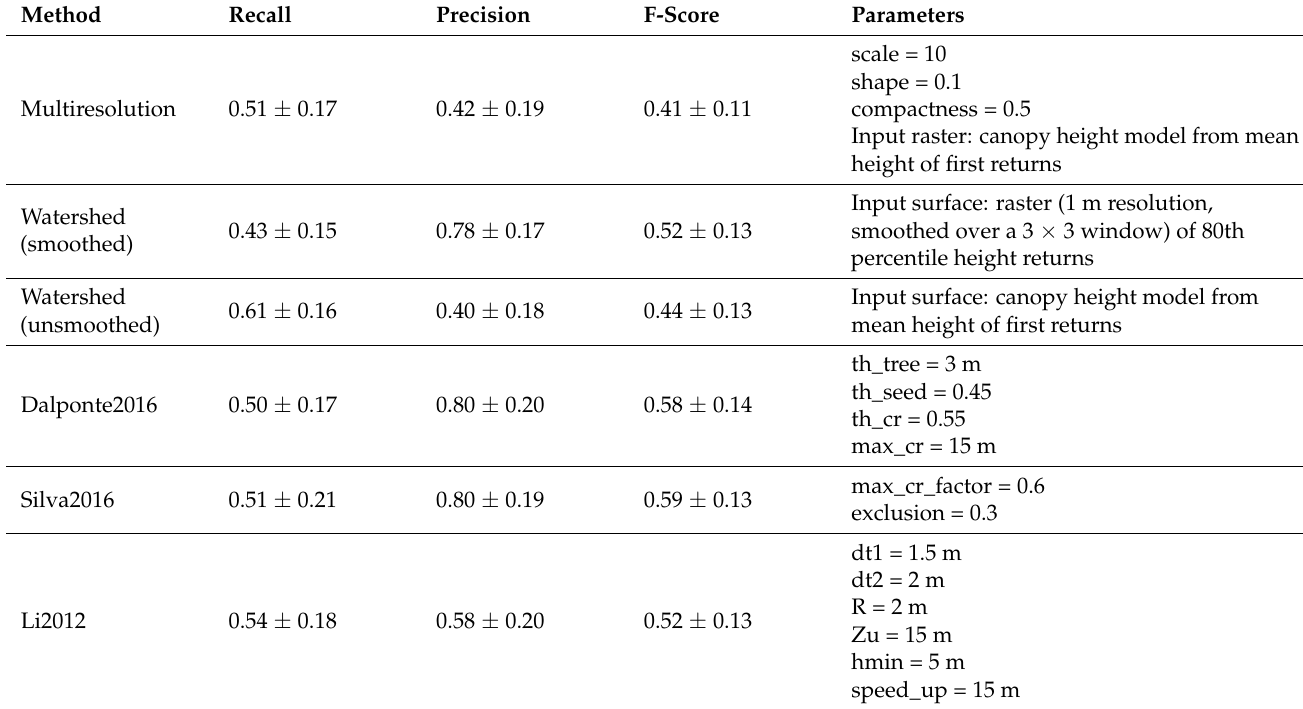
Table 4. Comparison of accuracy metrics for all segmentation methods. Recall, precision, and F-score were calculated separately for each ground-truth plot ( n = 97), and then averaged to give overall scores for the study area. Means are given ± standard deviation. Metrics shown are for dominant stems only. See Roussel and Auty [46] and Trimble [45] for parameters.